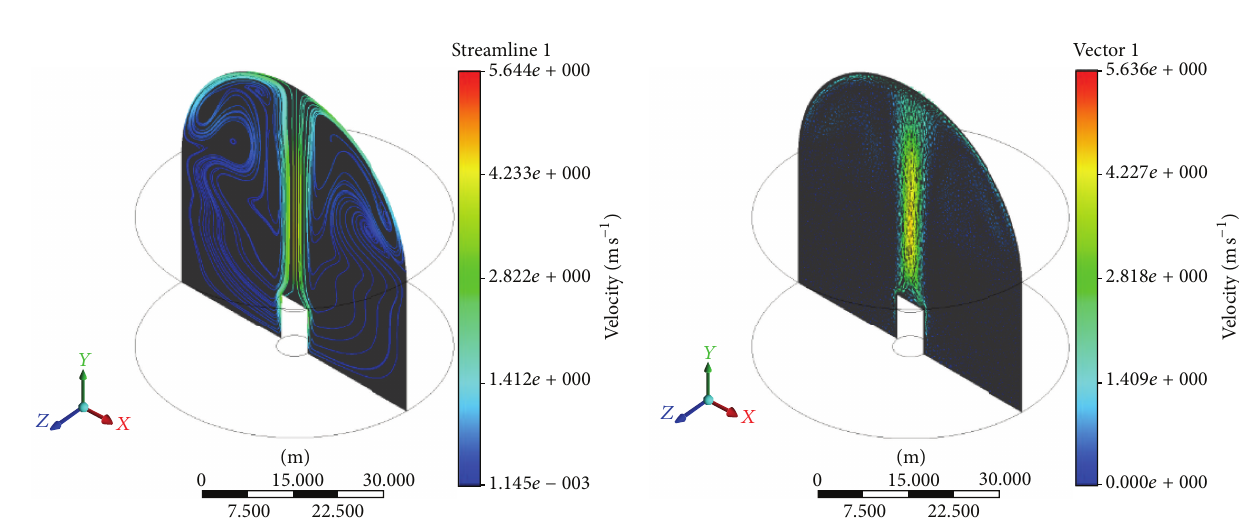
Figure 6: Stream lines and velocity vector at